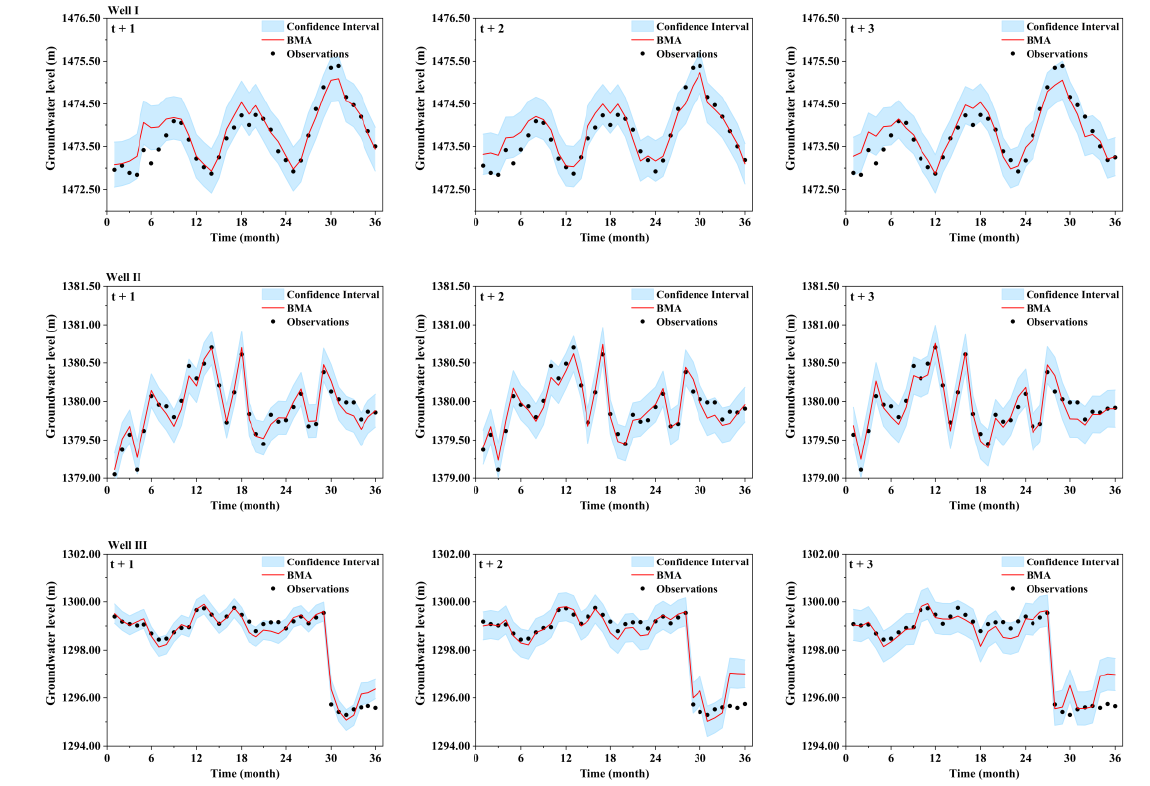
Figure 6. Uncertainty analysis of the BMA-predicted GWL for Wells I, II, and III at 1-, 2-, and 3-month-ahead GWL prediction horizons under the 95% confidence interval.